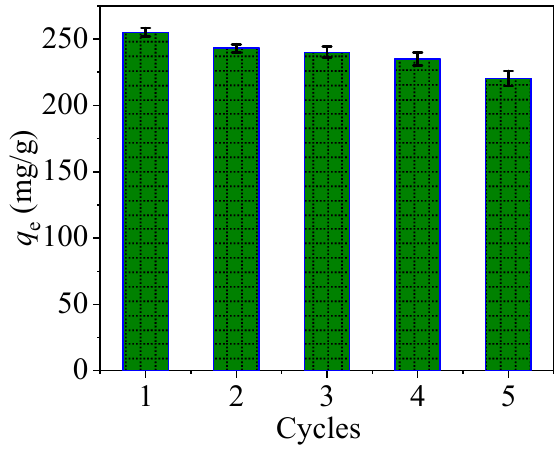
Figure 13. Adsorption performance after repeated use of PPy-Fe 3 O 4 /Kaolin (pH = 7, C 0 = 40 mg/L, T = 298 K, t = 7 h and dosage of 0.05 g/L).